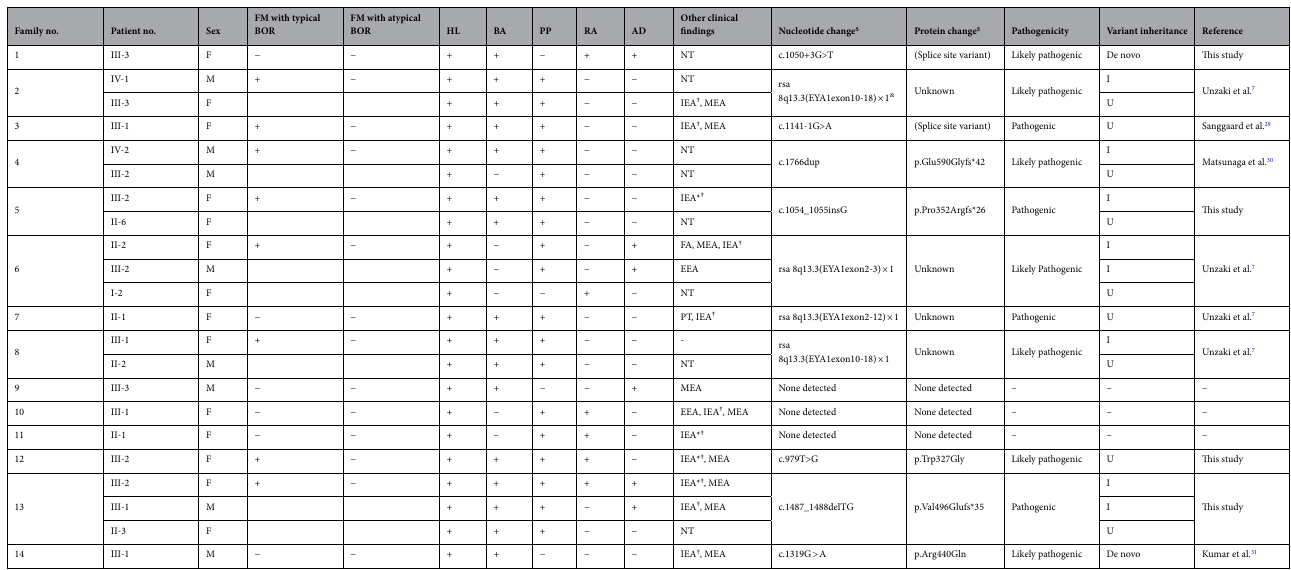
tified. Among three sporadic cases with LP variants (Families 1, 7, and 14), parent samples were available for two (Families 1 and 14), in which LP variants were determined to be de novo. The large deletions detected by